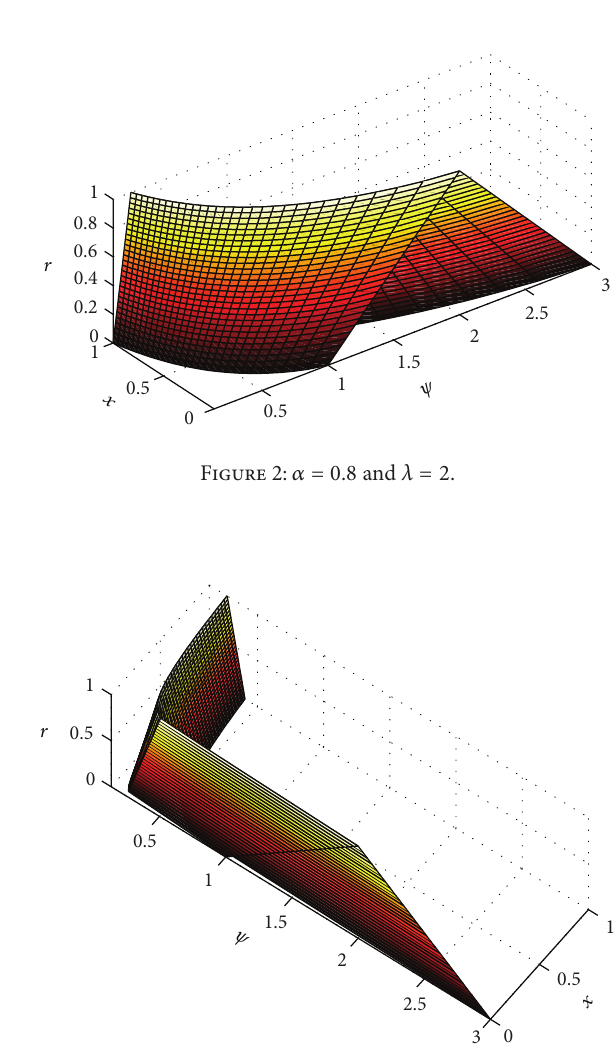
Figure 1: 𝛼 = 0.3 and 𝜆 = 2 .